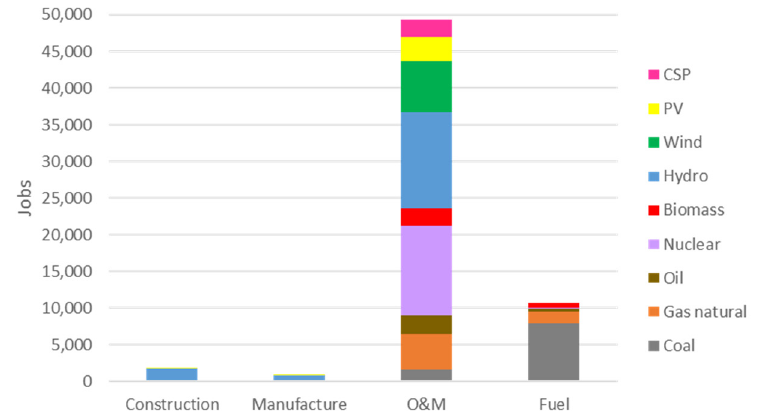
Figure 15. Breakdown of direct employment generation by power generation technology (2015).